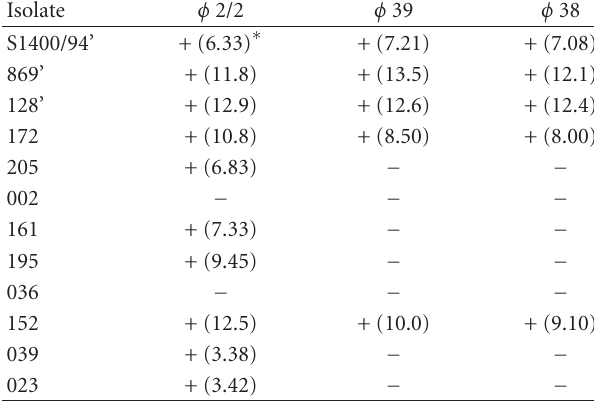
Table 1: Susceptibility of tested bacteria to phages according to spot test